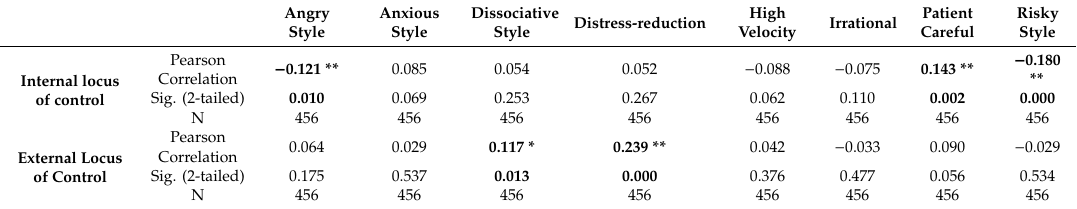
Table 1. Correlations between the driving styles and the internal and external tra ffi c locus of control.